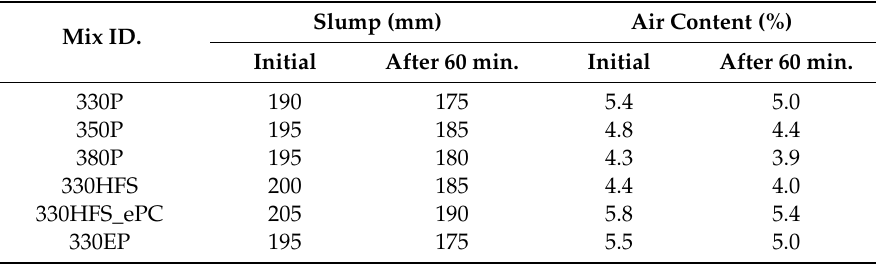
Table 5. Fresh properties on